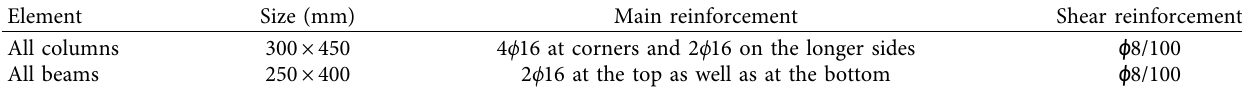
Table 4: Detailed information about column and beam cross-sections of the building.